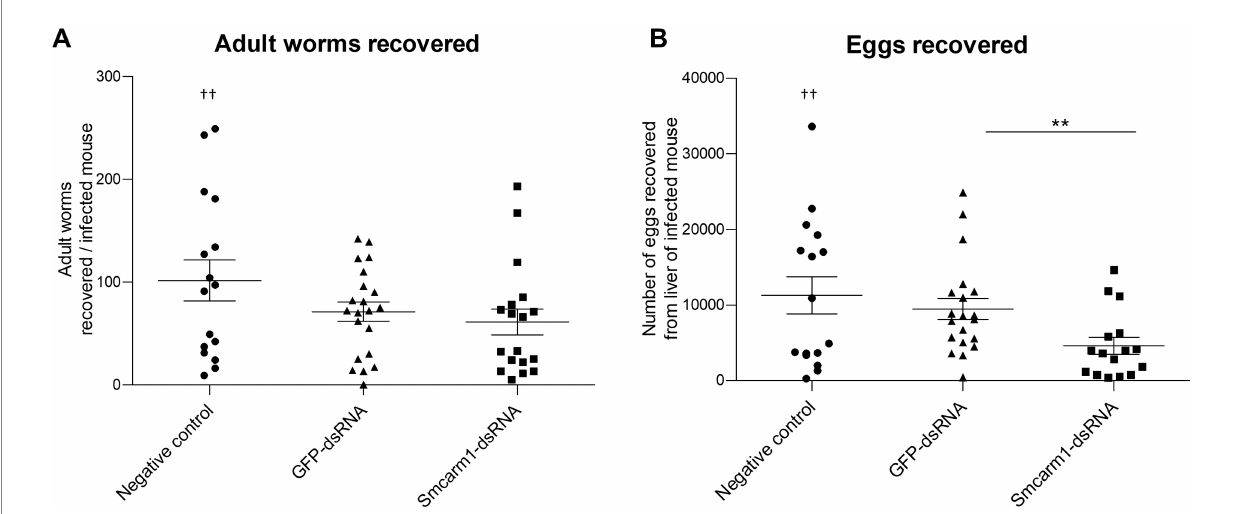
FIGURE 4 Analysis of ex vivo adult worms and evaluation of egg recovery from mice liver. Adult worms recovered from mice infected with schistosomula from negative control ( ● ), unspecific GFP-dsRNA ( ▲ ), and Sm carm 1-dsRNA ( ■ ). Each symbol in the chart represents (A) worm counts per mouse or (B) egg counts per mouse liver. Dead mouse is represented (†) above the plotted data. The horizontal lines represent the median values per group. Data were generated from three independent experiments and statistically analyzed using the Mann–Whitney test. ** p < 0.01.